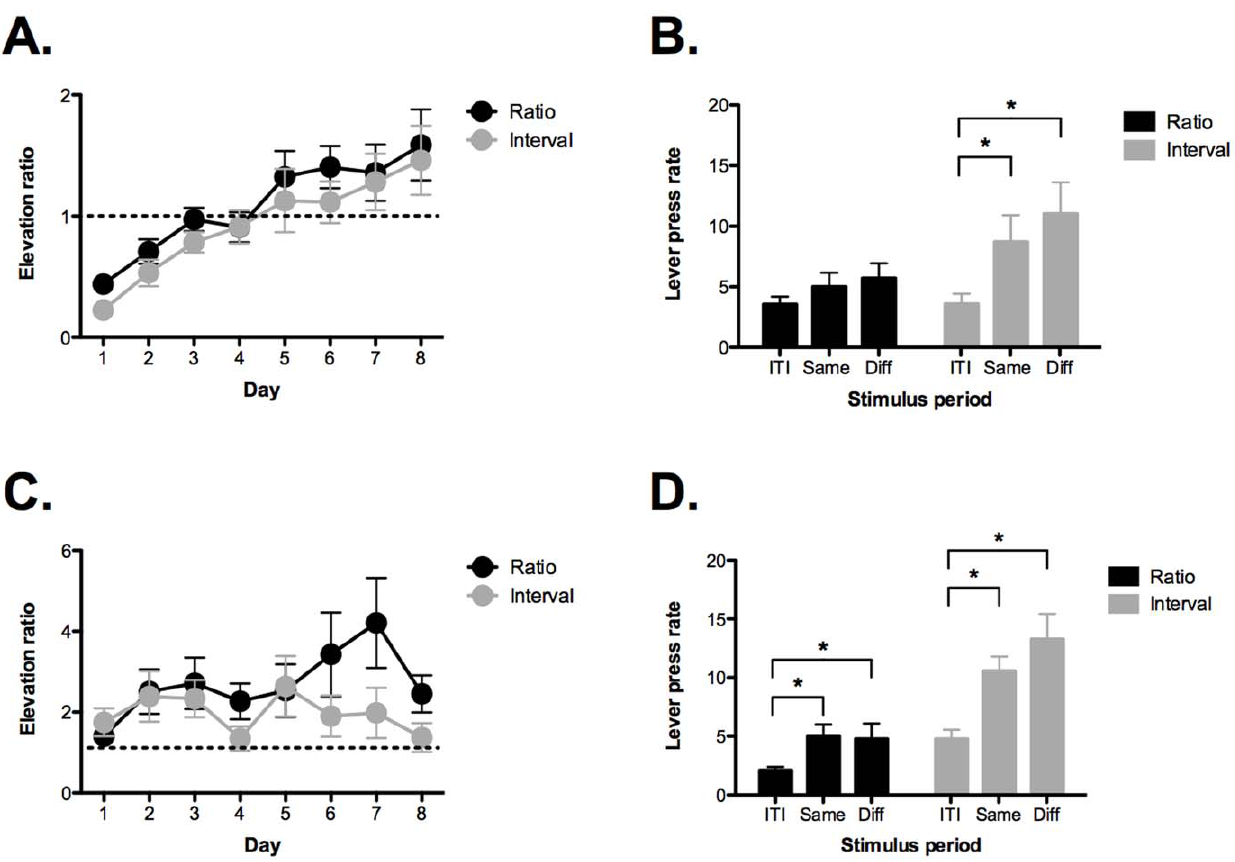
Figure 2. Reward cues motivate habitual responses more than goal-directed actions. A) Mice underwent Pavlovian conditioning for 8 days where conditional stimuli (CSs) were paired with the same food rewards used in instrumental training. Both ratio and interval groups showed an increase in conditional responding (magazine entries) across training days. The data are expressed as an elevation ratio = (CS entries/ITI entries). B) During the transfer test, mice trained on ratio schedules did not show an increase in lever pressing when the CSs were presented. In contrast, mice trained on interval schedules showed a significant increase in lever pressing during the CS presentations relative to the ITI period. This increase was not selective as it was observed on the lever leading to the same outcome as the CS and the lever leading to a different outcome (i.e. general transfer). C) Mice underwent additional Pavlovian training for 8 days. D) A second transfer test was conducted and this time mice trained on ratio schedules showed a significant increase in lever pressing when the CSs were presented. This increase was not selective and observed on both